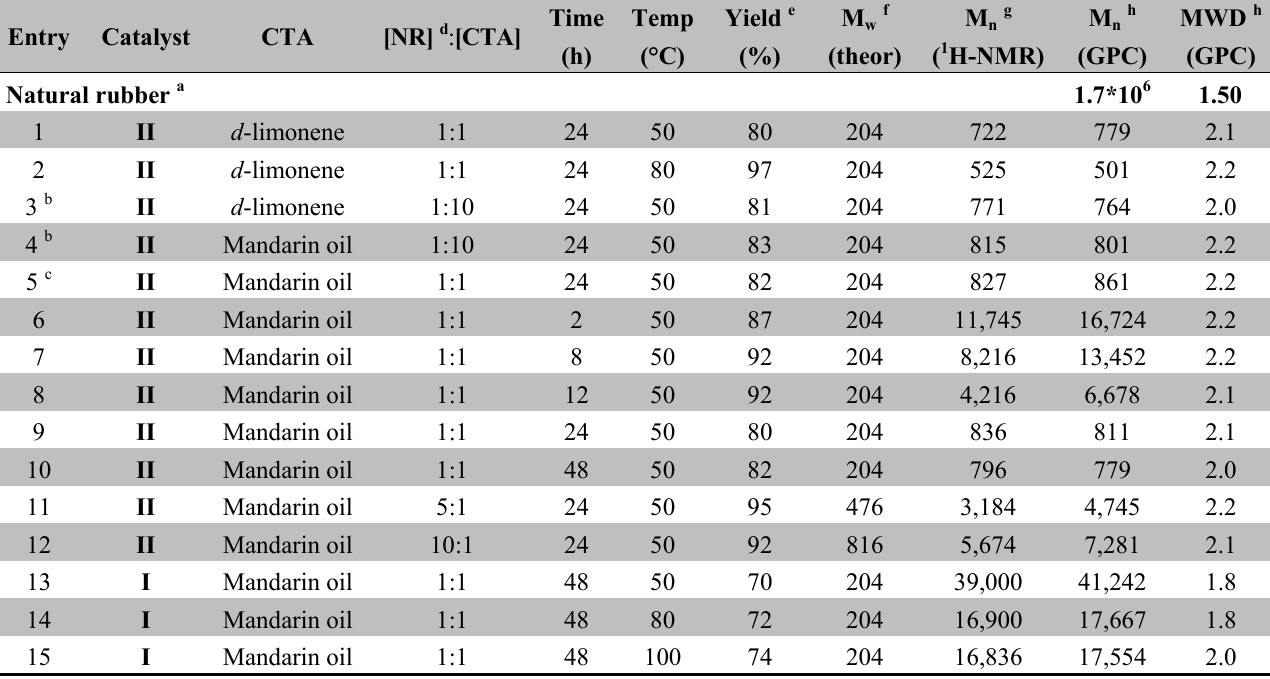
Table 2. Degradation of NR with mandarin oil and d -limonene (degradation in bulk, molar ratio NR/Catalyst I and, NR/catalyst II =